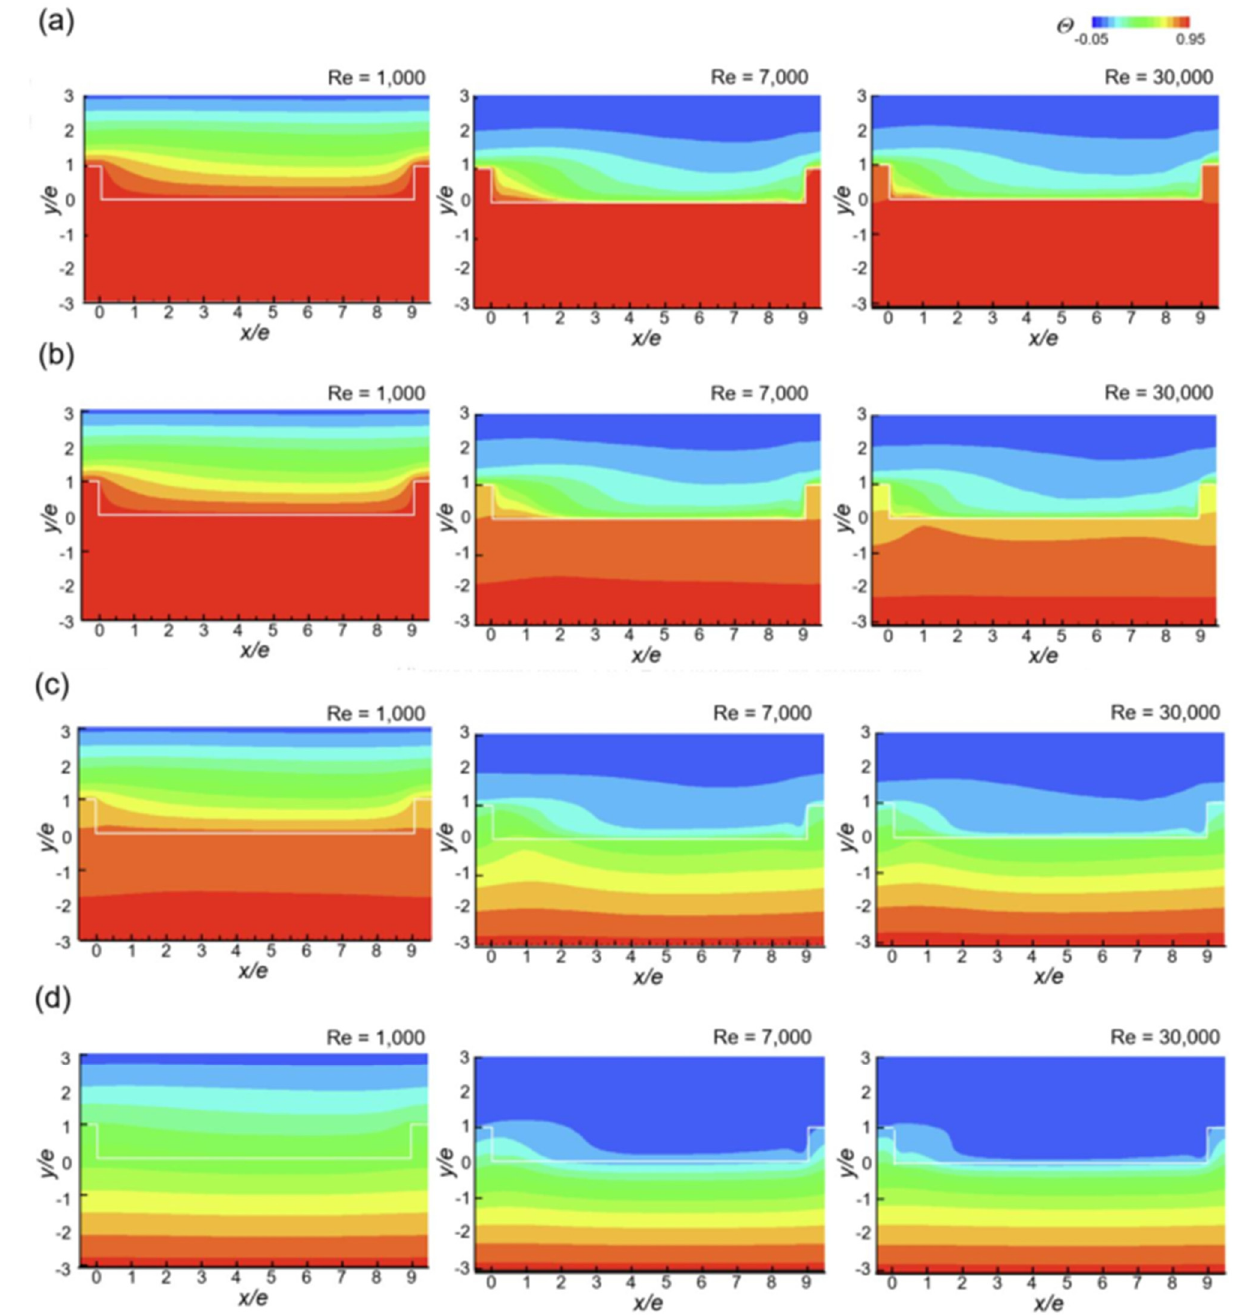
Figure 5. Time-averaged temperature fields; ( a ) K * = 566.26, ( b ) K * = 100.00, ( c ) K * = 10.00, and ( d ) K * = 1.00.